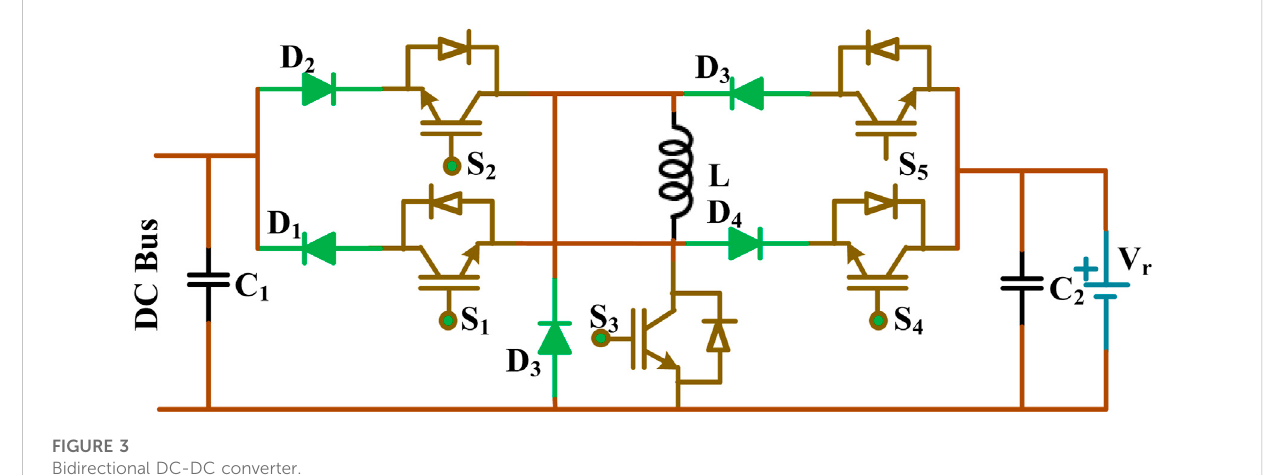
FIGURE 3 Bidirectional DC-DC converter.